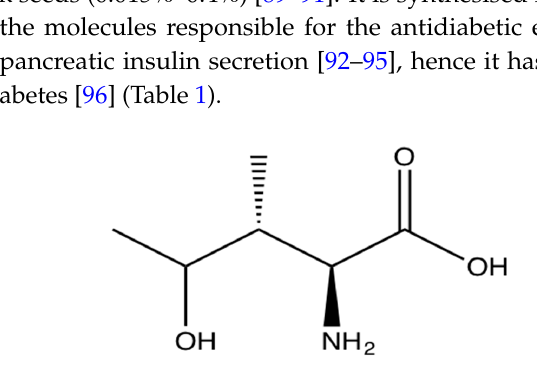
Figure 2. The branched-chain amino acid (2 S , 3R , 4S) -4-hydroxyisoleucine.